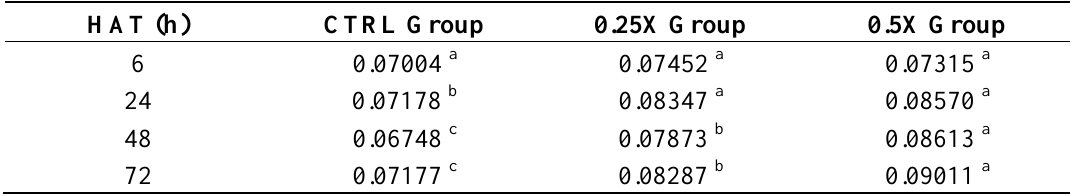
Table 7. FCA calculated for experimental cotton leaves of the three groups at 6, 24, 48, c 72 HAT. Each value is a mean of six leaves for the same group. The statistics are analyzed by Duncan’s multiple range tests * .